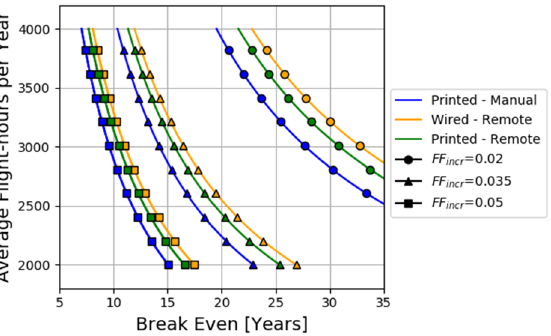
Figure 11. Estimation of the break-even point in years for different combinations of AvgFLY and FF incr